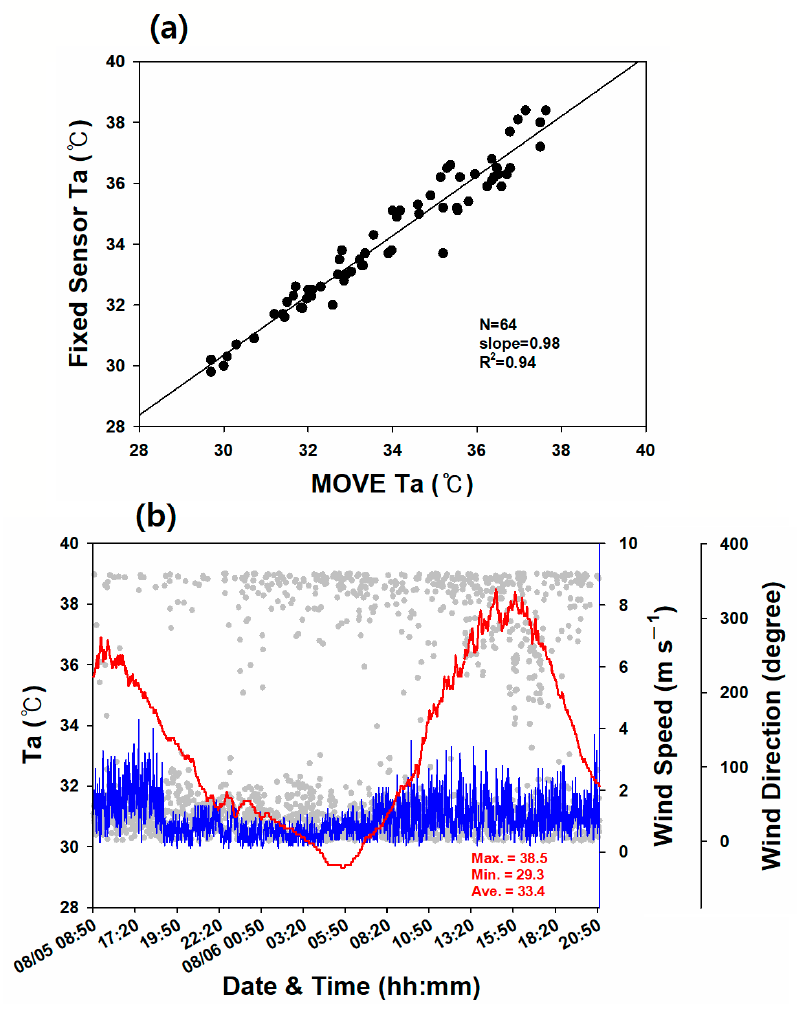
Figure 4. ( a ) Comparison between air temperatures from two fixed sensors (R2 and R3) and MOVE, and ( b ) time series of air temperature (left axis), wind speed and wind direction (right axis) at site R1, as marked in Figure 1 during the observation period of MOVE.